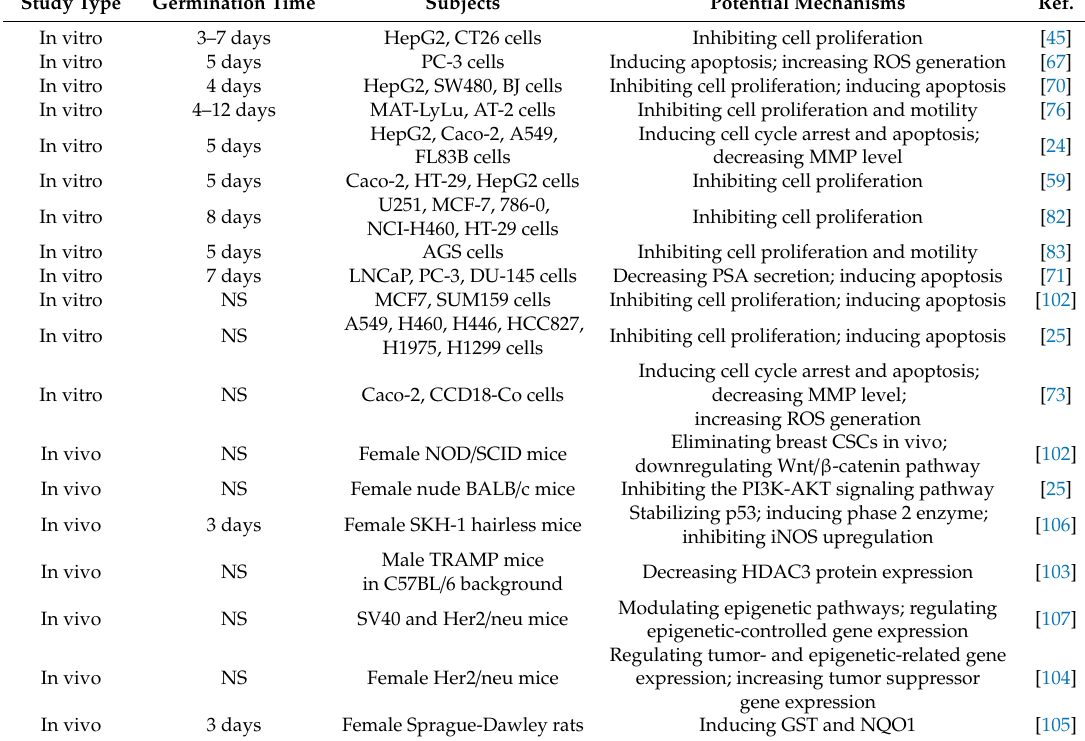
Table 5. Anticancer activity of broccoli sprouts and